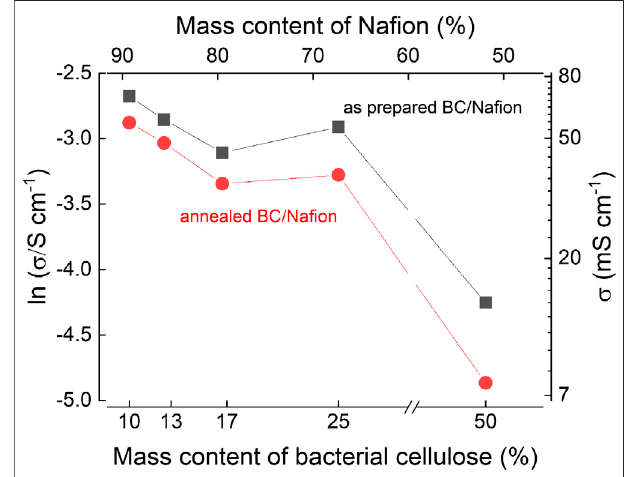
FIGURE 7 | Arrhenius plot of the DC conductivity of different cellulose samples measured as a function of temperature (after pre-heating samples at 110 ° C, anhydrous conditions). The solid lines show the best fi t of the Arrhenius equation to the experimental points with activation energy values, Ea, equal to 104 kJ · mol -1 (1.07 eV) for CNC fi lm and 74 kJ mol -1 (0.76 eV) for CNC powder. Redrawn from (Jankowska, et al.,